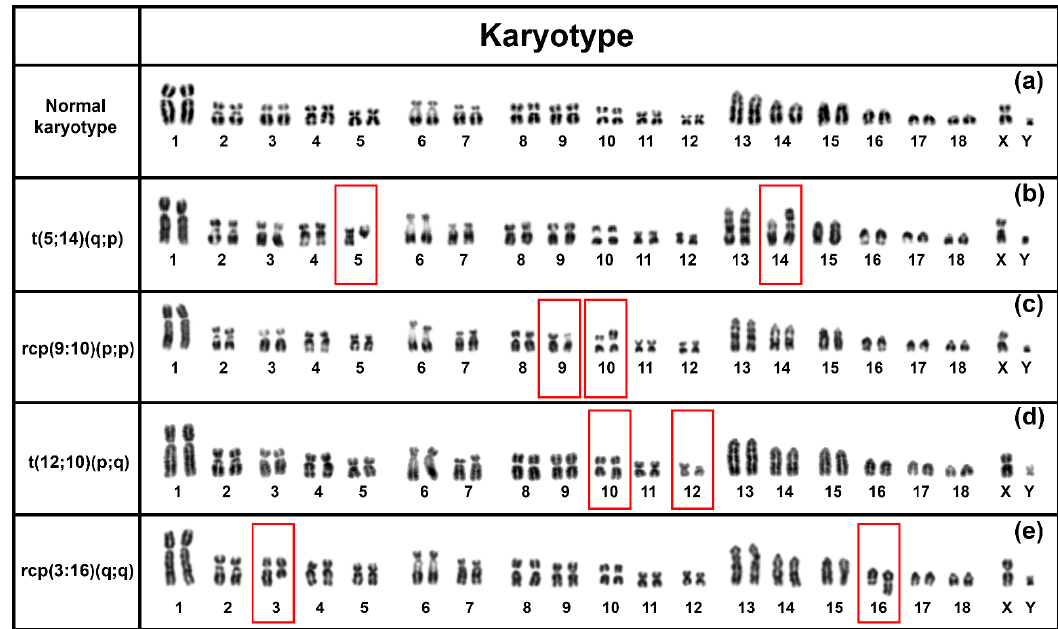
Figure 1. DAPI-stained karyotype of a normal boar with no chromosomal rearrangement ( a ) and four balanced chromosomal rearrangements identified in an Australian nucleus herd ( b – e ). Red boxes indicate the chromosomes involved in the rearrangement.